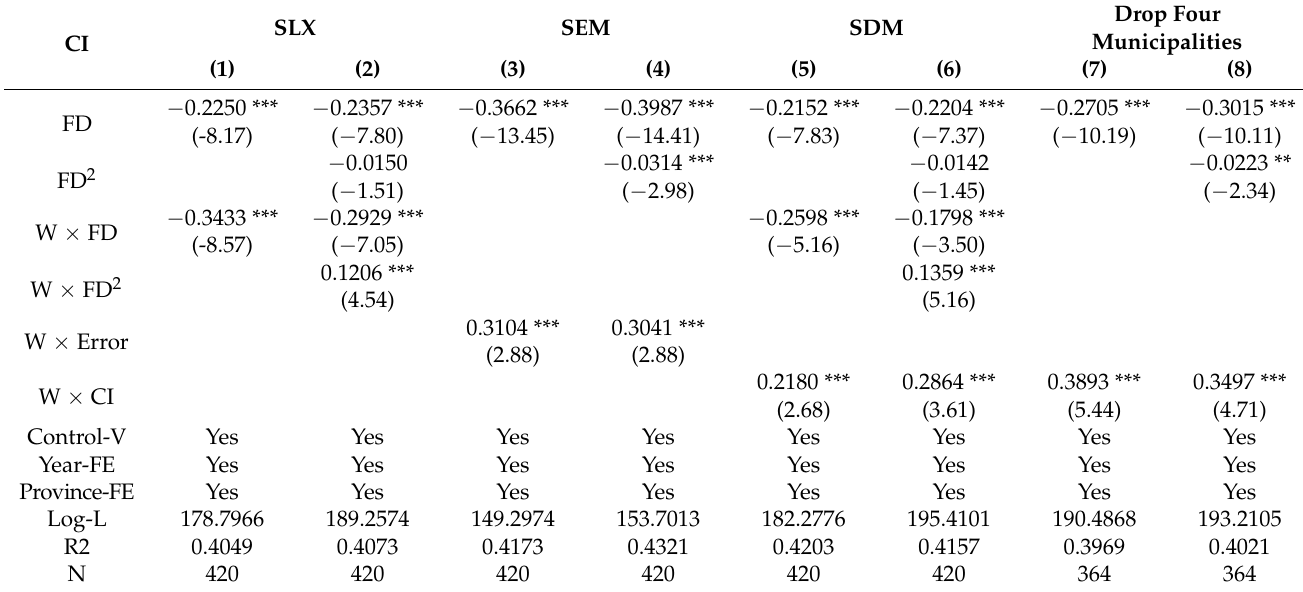
Table 6. Results of robustness